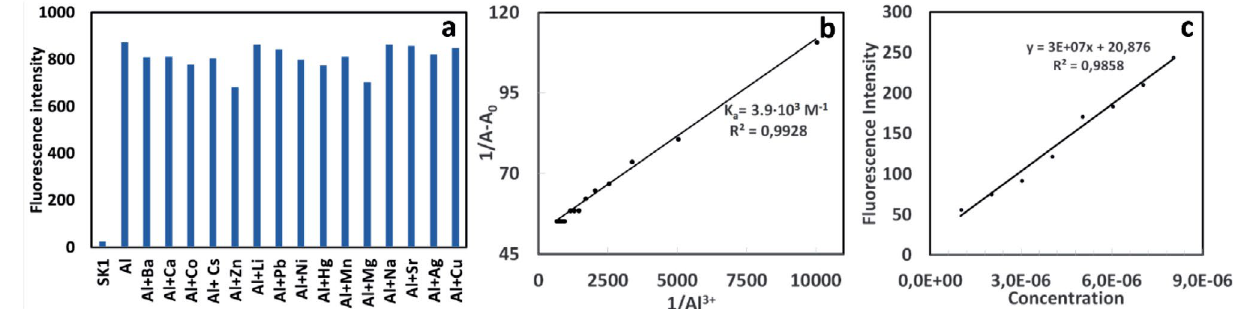
Fig. 5. Fluorescent selectivity of SK-1 (1µM) at 530 nm upon addition of various metal ions (10µM) Li + , Na + , Ag + , Ca 2+ , Ba 2+ , Co 2+ , Cs + , Cu 2+ , Mg 2+ , Hg 2+ , Mn 2+ , Pb 2+ , Ni 2+ , Sr 2+ , and Zn 2+ , λ ex = 430 nm. (b) Calculation of binding constant between SK-1 and Al 3+ . A 0 is the absorbance of free SK-1 solution (1µM); A is the absorbance of compound SK-1 solution (1µM) upon addition of different amounts of Al 3 , (c) Calculation of detection limit of SK-1 for Al 3+ with excitation at 430 nm and emission at 530 nm by addition of different amounts of Al 3+ to SK-1 solution (1µM)